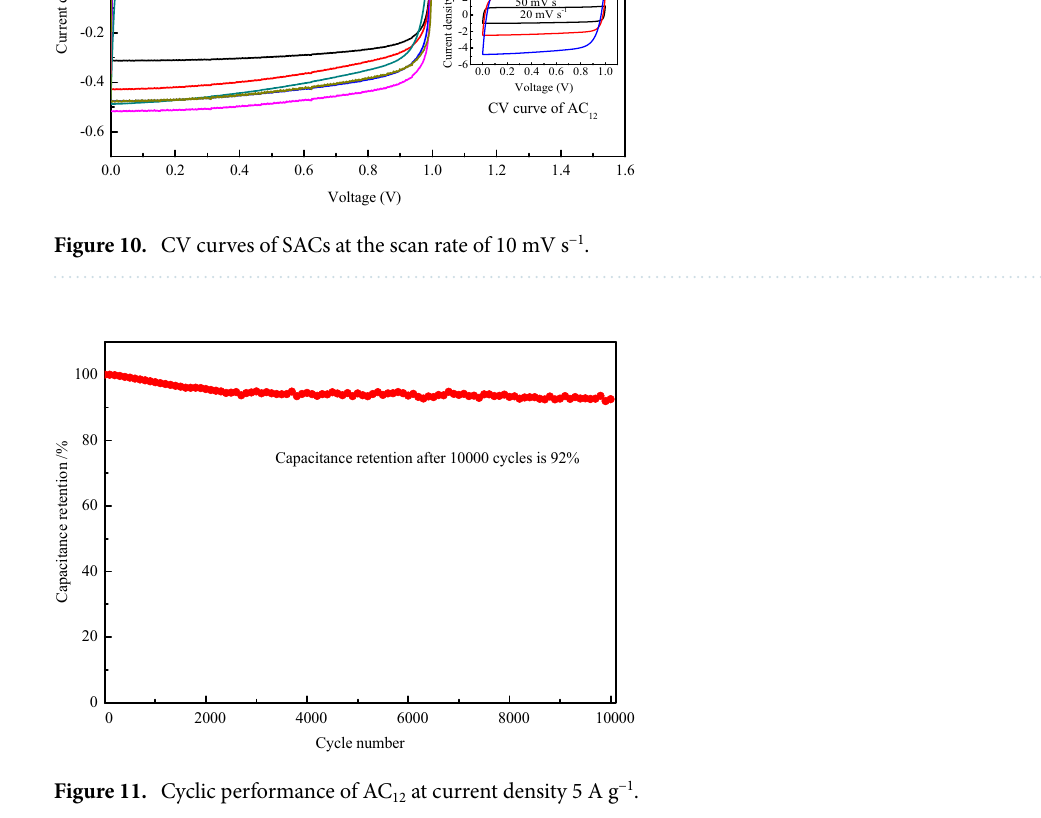
Cyclic voltammetry characteristics of SACs. The CV curves of SACs at the scan rate of 10 mV s −1 are shown in Fig. 10. The CV curves of the SACs show excellent symmetry and approximate rectangular shape, which indi- cates that the energy storage mode of the activated carbon electrode is basically electric double layer capacitance, without the existence of pseudo capacitance. In Fig. 11, the inherent stability of activated carbon and pure elec- tric double layer energy storage contribute to the excellent cycle stability of activated carbon. With the increase of voltage scanning rate, the gradual weakening of the rectangular characteristics of CV curve is observed. Due to the existence of the dispersed capacitance effect, the speed of current reaching the platform at the time of changing the voltage scanning direction is delayed, resulting in the disappearance of the standard rectangular characteristic of the CV curve. However, even at the voltage scanning rate of 100 mV s −1 , the CV curve of acti- vated carbon still shows a good rectangular characteristic, which indicates that the electrode material has a rapid ion response ability, and the pore structure of the activated carbon can meet the rapid diffusion and transmission of electrolyte ions in the carbon electrode. The cyclic stability of activated carbon is closely related to the service life of supercapacitors, and even deter- mines whether supercapacitors can be used in practice. Figure 11 shows the cyclic characteristics of AC 12 at a current density of 5 A g −1 for 10,000 cycles. Since the energy storage in supercapacitors are highly dominated by the double layer capacitance, the charge and discharge processes are almost completely reversible. The capacitance retention rate of AC 12 is as high as 92% after 10,000 times of constant current charge and discharge, indicating that activated carbon has excellent cycling stability. Moreover, the decay of the carbon electrode capacitance mainly occurs in the first 3000 cycles, after which the capacitance of the activated carbon remains at a relatively stable level. After 3000 cycles of charge and discharge, the irreversible reaction on the carbon electrode basically disappears, and the energy storage mode of the supercapacitor is transformed into complete electric double-layer energy storage. The absence of the conversion between electric energy and chemical energy makes the capaci- tance decay in the cycle process almost negligible. The capacitance decay in the second stage is mainly caused by the collapse and damage of carbon electrode pore structure during charge and discharge. The insignificant capacitance decay shows that activated carbon has good chemical stability in KOH electrolyte.